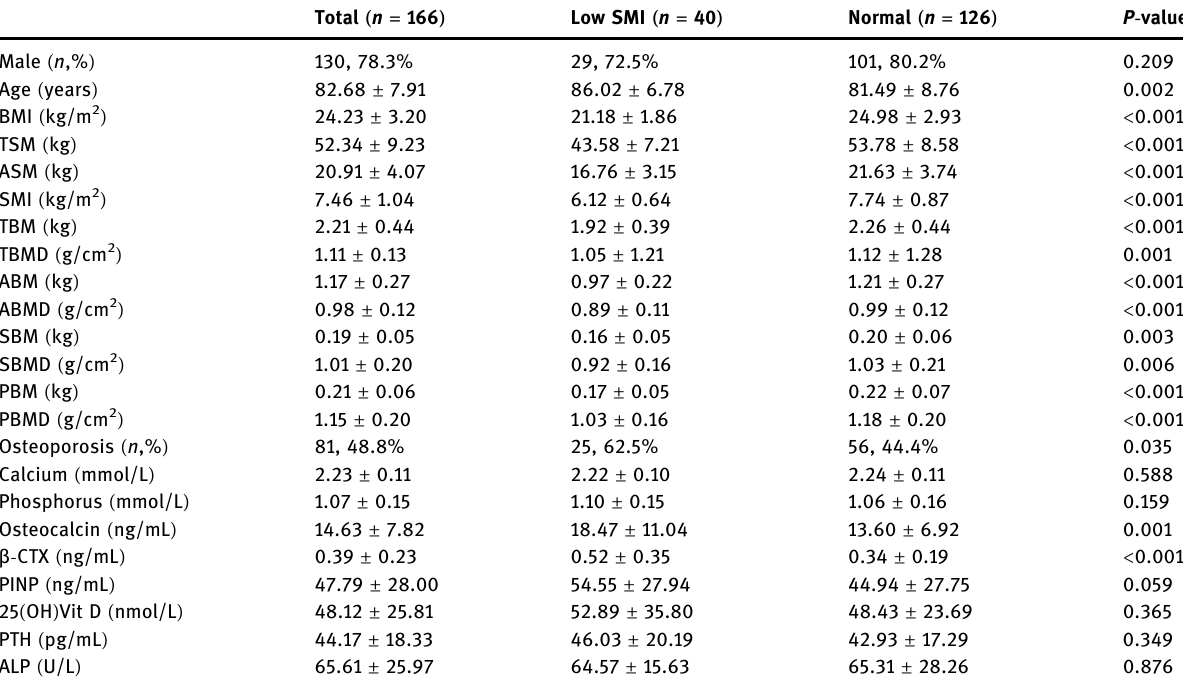
Table 1: Characteristics of the